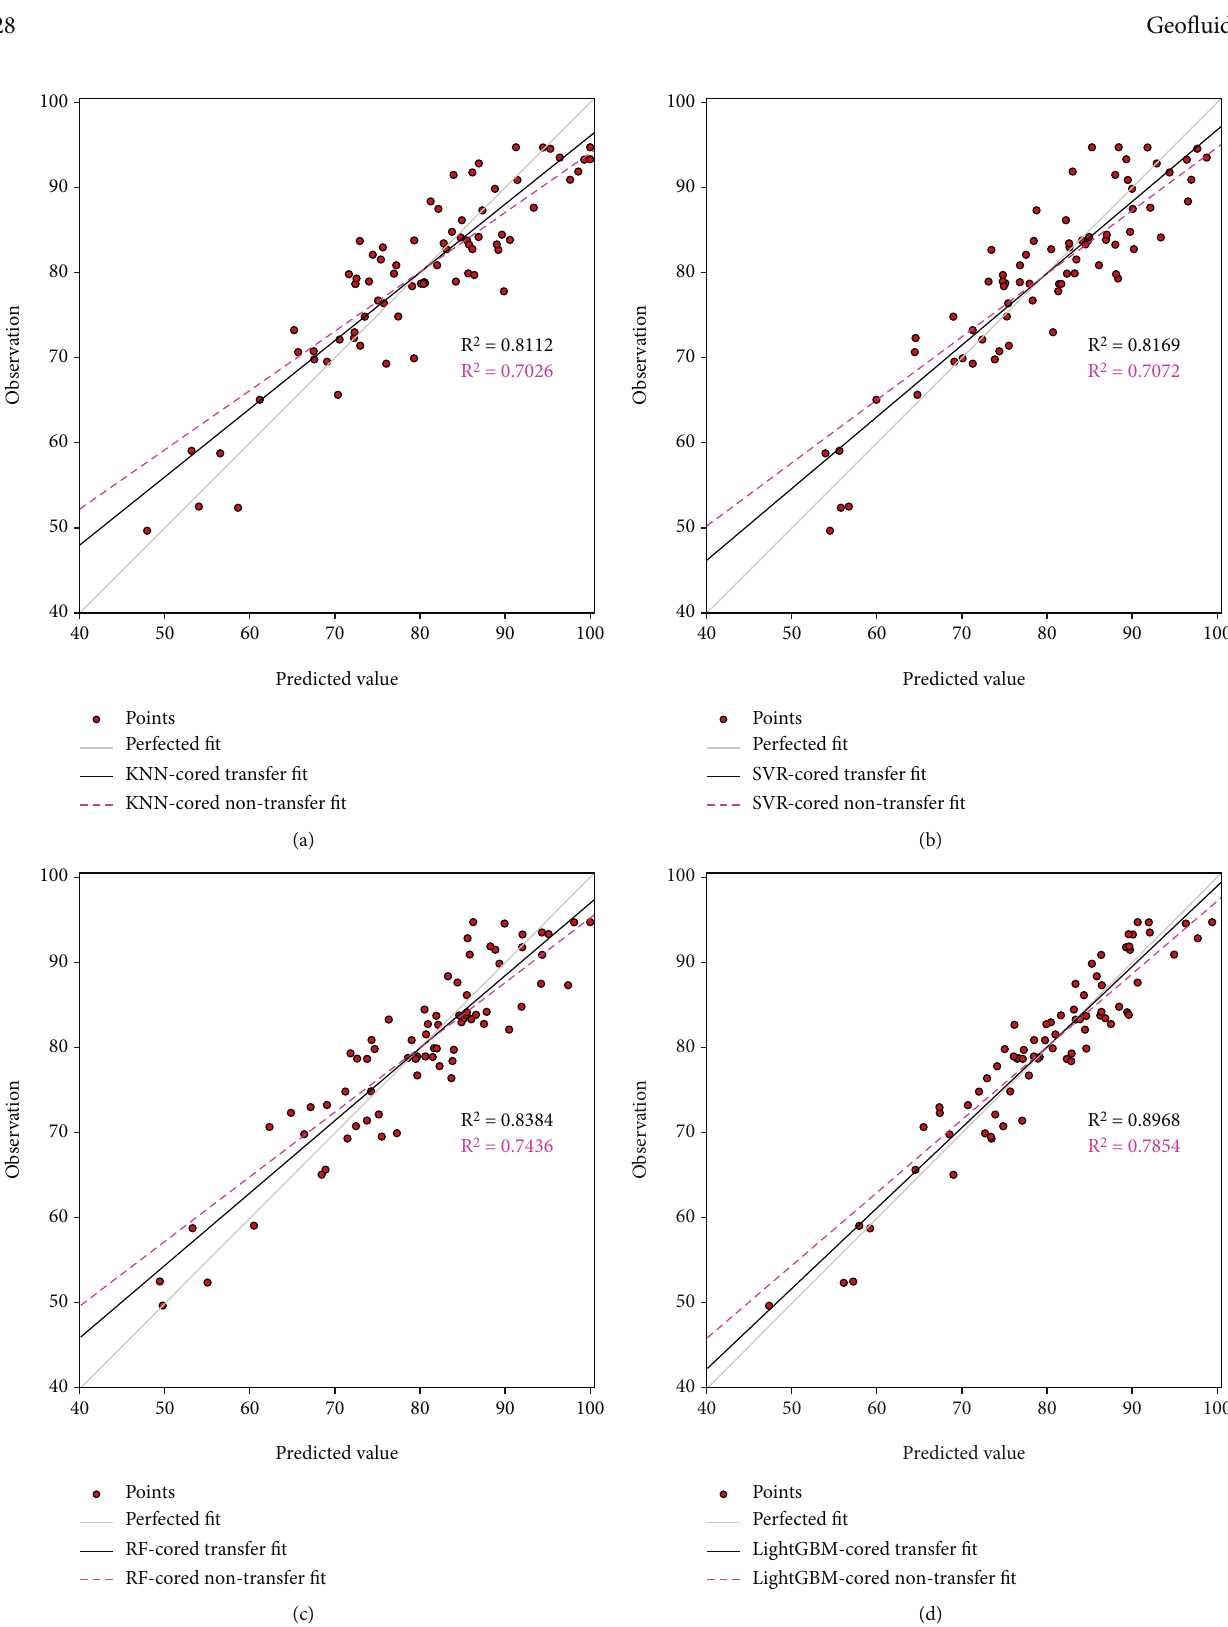
Figure 17: Fitness of water saturation results provided by KNN-cored predictor (a), SVR-cored predictor (b), RF-cored predictor (c), and LightGBM-cored predictor (d) in the third experiment. KNN =k-nearest neighbors; SVR =support vector regression; RF=random forest; LightGBM=light gradient boosting machine; RMSE =root-mean-square